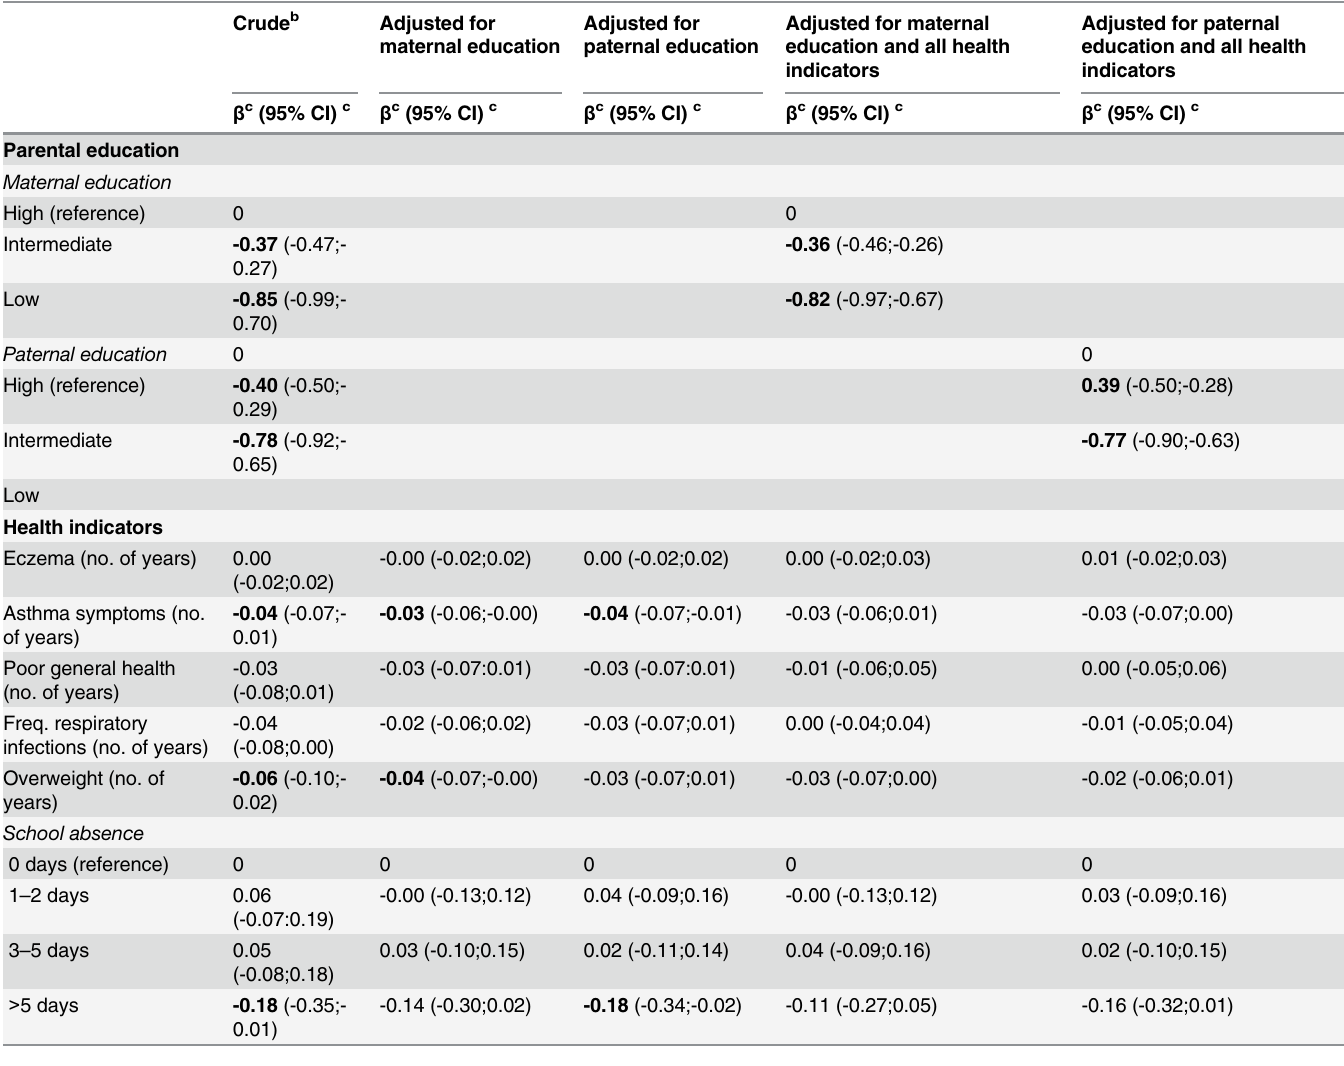
Table 4. Association of parental education and health indicators with Cito test score (Z-score) (n = 1,531) a . Adjusted for Crude b Adjusted for maternal education paternal